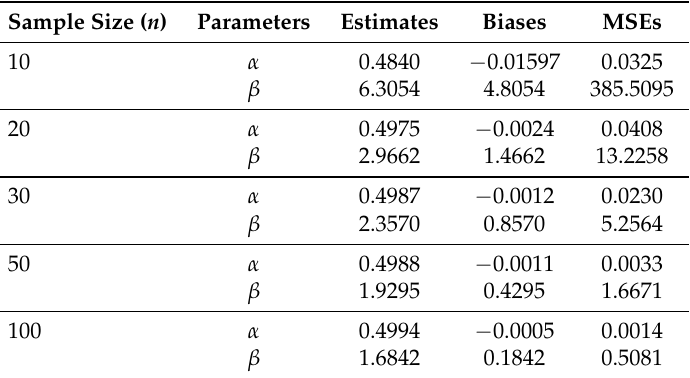
Table 5. Estimates, biases and MSEs for α = 0.5 and β = 1.5.